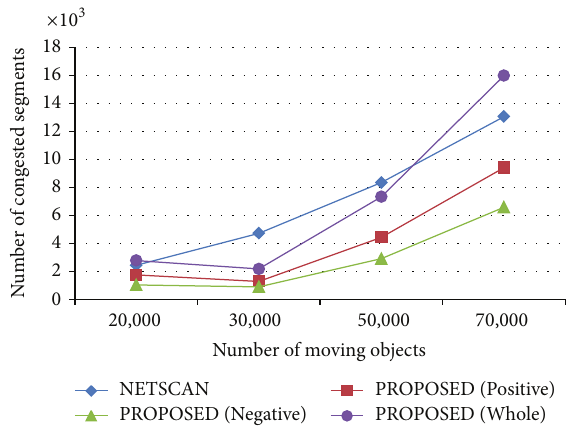
Figure 6: The number of congested routes according to the number of vehicles.